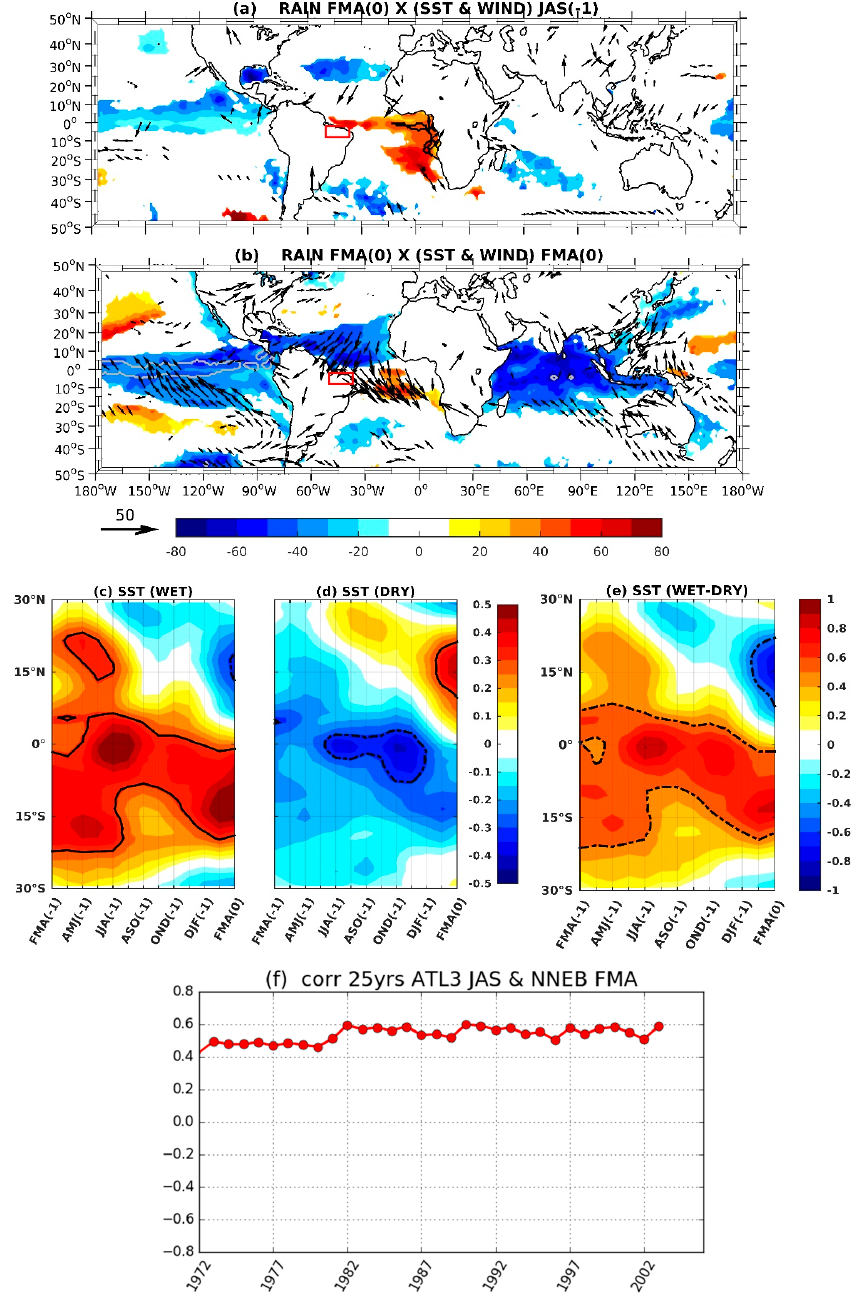
Figure 5. Distributions of lagged linear correlation / regression (mm month − 1 / ◦ C) of the gridded SSTA in: ( a ) JAS( − 1) and ( b ) FMA(0) with rainfall anomalies in Northern NEB (red box) during FMA(0) for the period 1960–2015. The vectors represent the linear regression (mm month − 1 / m s − 1 ) of the gridded surface wind vectors (u and v) with rainfall anomalies in Northern NEB. The significant correlations at a 95% confidence level, according to the t -test, are plotted for both SST and wind. Contours indicate regions of correlation higher than + 0.5 (solid black line) and lower than − 0.5 (solid gray line). Longitude–time diagrams of the composites of standardized SSTA for: ( c ) WET years, ( d ) DRY years, and ( e ) di ff erence WET–DRY years for the period 1960–2015. The SSTA are averaged between 60 ◦ W–15 ◦ E. Values in Figure 5d are shown where the di ff erence is significant at a 95% confidence level using the t -test. ( f ) Running correlation of 25 year (centered) windows between JAS( − 1) Atlantic Niño (ATL3) SSTA and FMA(0) Northern NEB rainfall anomalies. Dots indicate correlation significant at a 95% confidence level according to the t